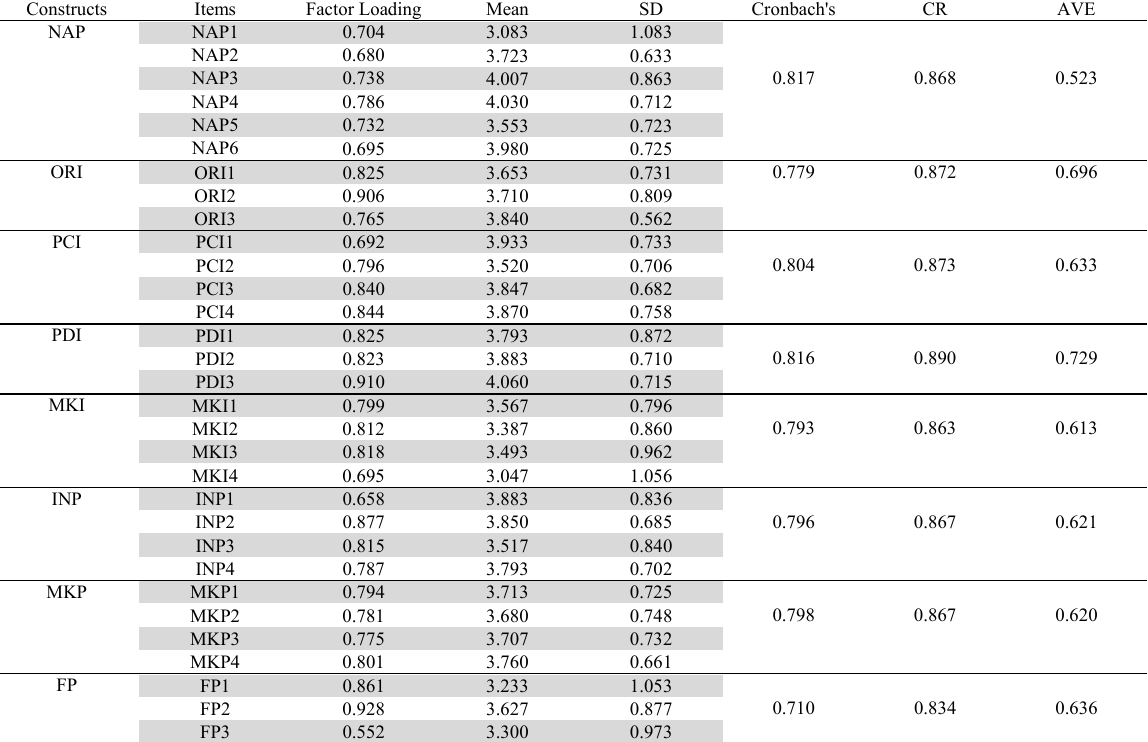
Descriptive and Measurement Assessment